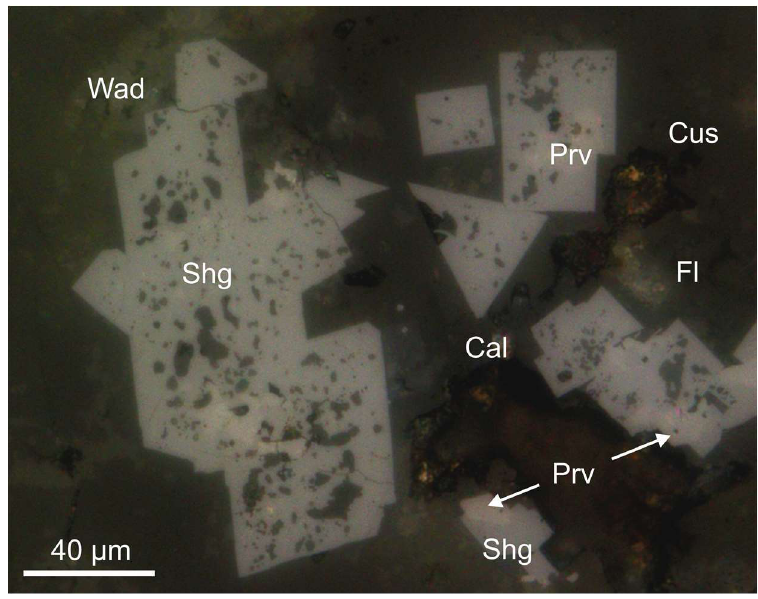
Figure 4. Sharyginite crystals with characteristic yellowish brown internal reflections from the Bellerberg volcano. Reflected light, crossed polarizers. Cal—calcite; Cus—cuspidine; Fl—fluorite; Prv—perovskite; Shg—sharyginite; Wad—wadalite. Quantitative reflectance measurements for sharyginite from the Bellerberg volcano were measured in air relative to a SiC standard using a UMSP 50D Opton microscope-spectrophotometer (Table 1). Reflectance percentages for the four R max and R min COM (Commission on Ore Mineralogy) wavelengths were: 16.1, 15.5 (470 nm); 14.9, 14.2 (546 nm); 14.6, 14.1 (589 nm), and 14.5, 13.9 (650 nm). Table 1. Reflectance values for sharyginite.